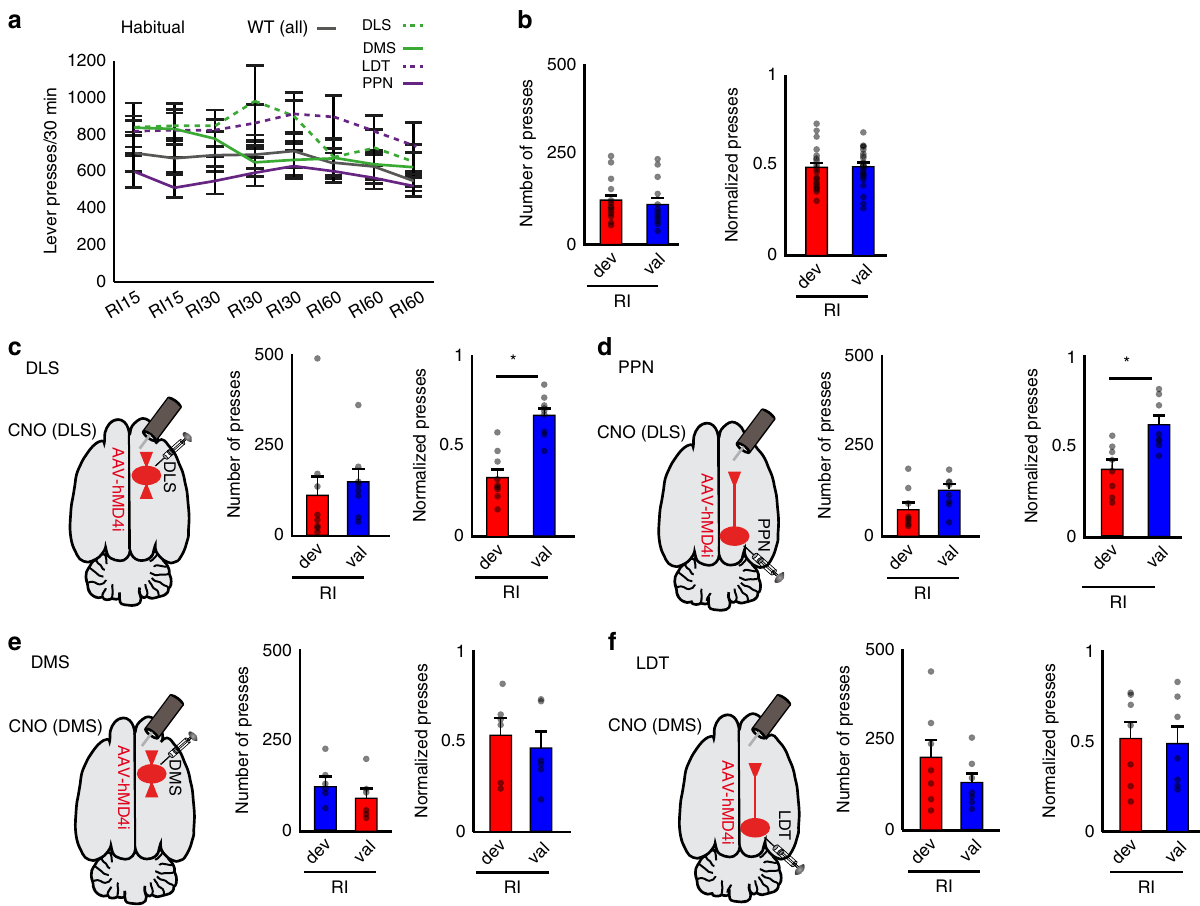
Fig. 7 Blocking of cholinergic transmission in the dorsal striatum impairs habitual action control. a Lever pressing during acquisition of habitual behavior shows no signi fi cant differences between groups (two-way ANOVA group × day: F group (4,359) = 2.30, P = 0.0581, F day (7,359) = 0.98, P = 0.4437; F = 0.36, P = 0.9991; n = 46). b Number of presses and normalized lever presses during outcome devaluation testing across valued (val, interaction (28,359) blue) or devalued (dev, red) states in random interval schedule (RI; habitual) in control animals. Neither the number of presses (mixed ANOVA: F group (3,16) = 1.16, P = 0.355; F session (1,16) = 0.16, P = 0.6957; F interaction (3,16) = 0.80, P = 0.5124) nor the normalized lever presses (mixed ANOVA group × session: F session (1,16) = 0.001, P = 0.9846, F interaction (3,16) = 0.1, P = 0.9576) showed signi fi cant differences. Control groups were then pooled into one single group. c – f ChAT::Cre animals were injected in the DLS c , PPN d , DMS e or LDT f . During RI, there were no differences in the number of presses (mixed ANOVA: groups × session [valued vs. devalued], F group (4,45) = 0.951, P = 0.444, F session (1,45) = 0.73, P = 0.3975, F interaction (4,45) = 2.31, P = 0.0719) but there was a signi fi cant interaction in the normalized number of presses (mixed ANOVA groups × session: F session (1,45) = 4.10, P = 0.0488; F = 3.0, P = 0.0282). Post hoc comparisons show a signi fi cant devaluation in DLS and PPN groups (see text for values), but not in the rest of interaction (4,45) the groups, suggesting that inhibition of PPN and DLS CINs axons prevents animals from developing habitual learning. Individual data points and mean ± SEM are shown. * P < 0.05. All experiments have been replicated at least three times.